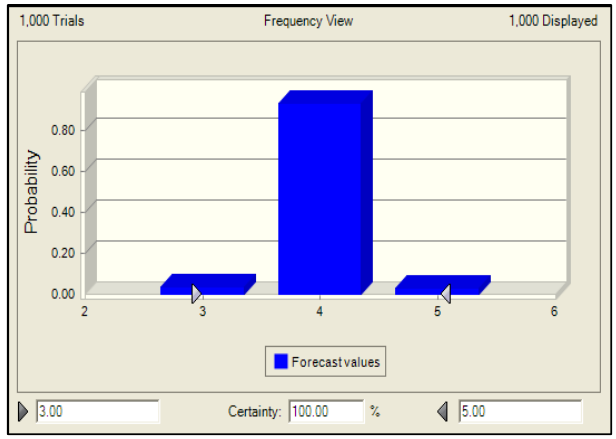
Figure 8 . Forecast values of the Monte Carlo simulation with 1000 trials according to research definition in CB software .